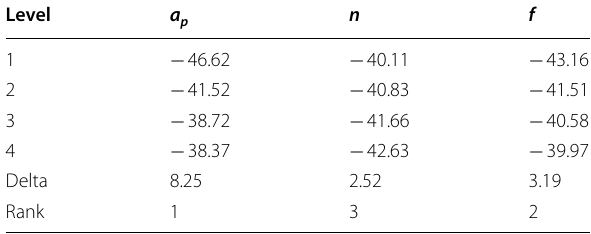
Table 5 S/N ratios of carbon emissions